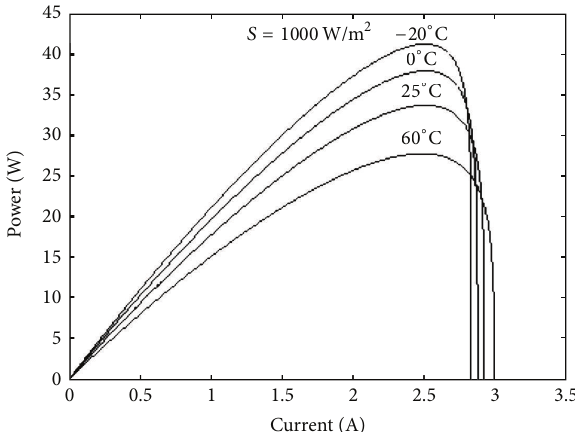
Figure 3: P-I characteristics of the solar array according to different temperature (for 𝑆 = 1000 W/m 2 ).